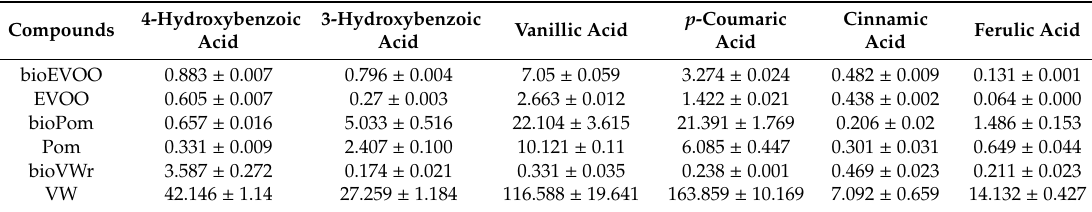
Table 4. Phenolic acids concentrations (mg /